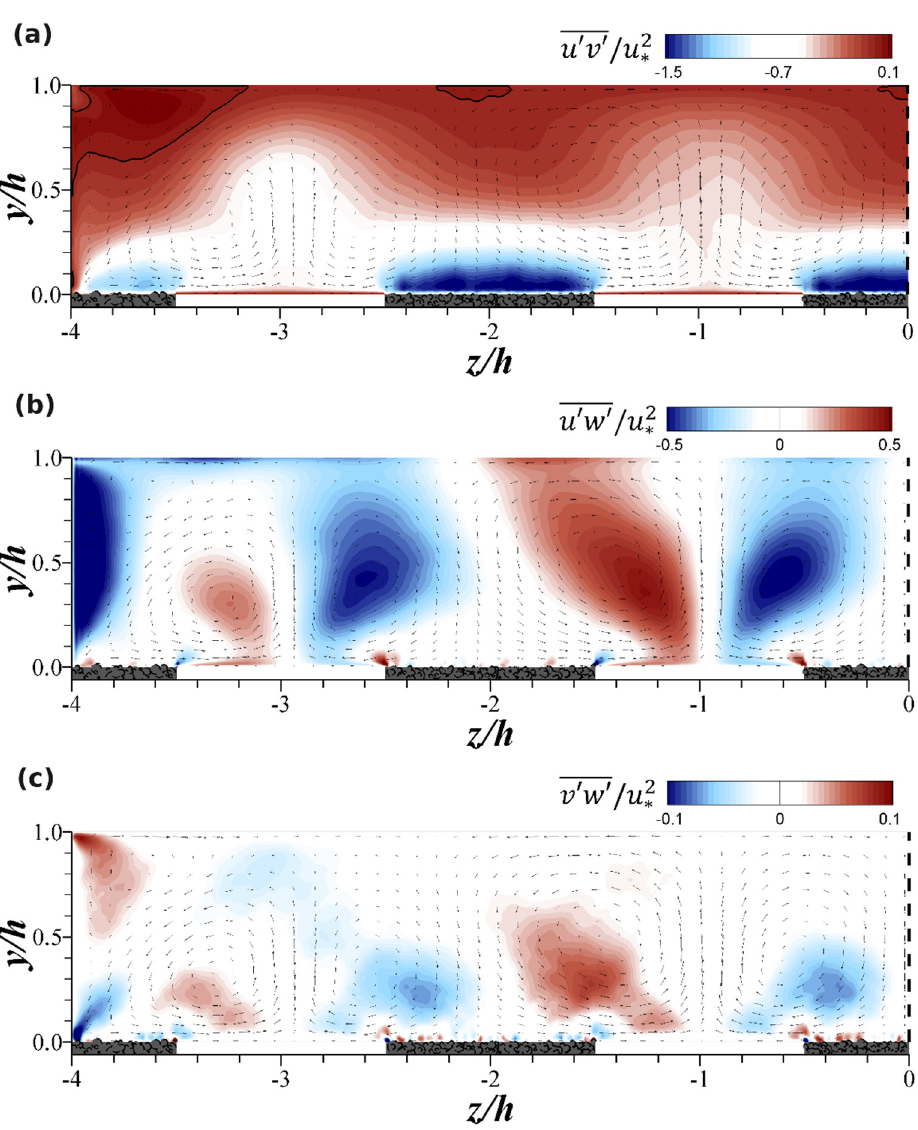
Figure 10. Contours of the normalized primary shear stress ( a ); normalized spanwise shear stress ( b ) and secondary shear stress ( c ) in the left half of the